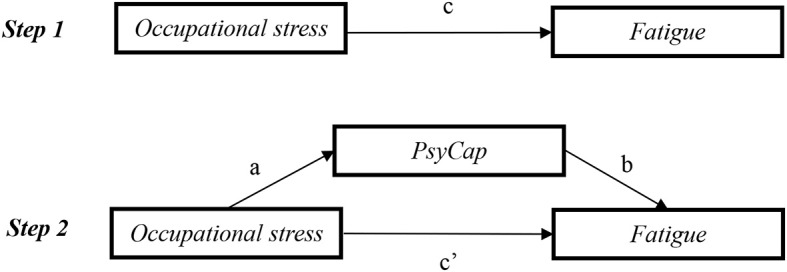
Mediating role of PsyCap in the association between occupational stress and fatigue. c, association of occupational stress with fatigue; a, association of occupational stress with PsyCap; b, association between PsyCap and fatigue after controlling for the covariates; c′ , association of occupational stress with fatigue after adding PsyCap as a mediator. PsyCap, psychological capital.